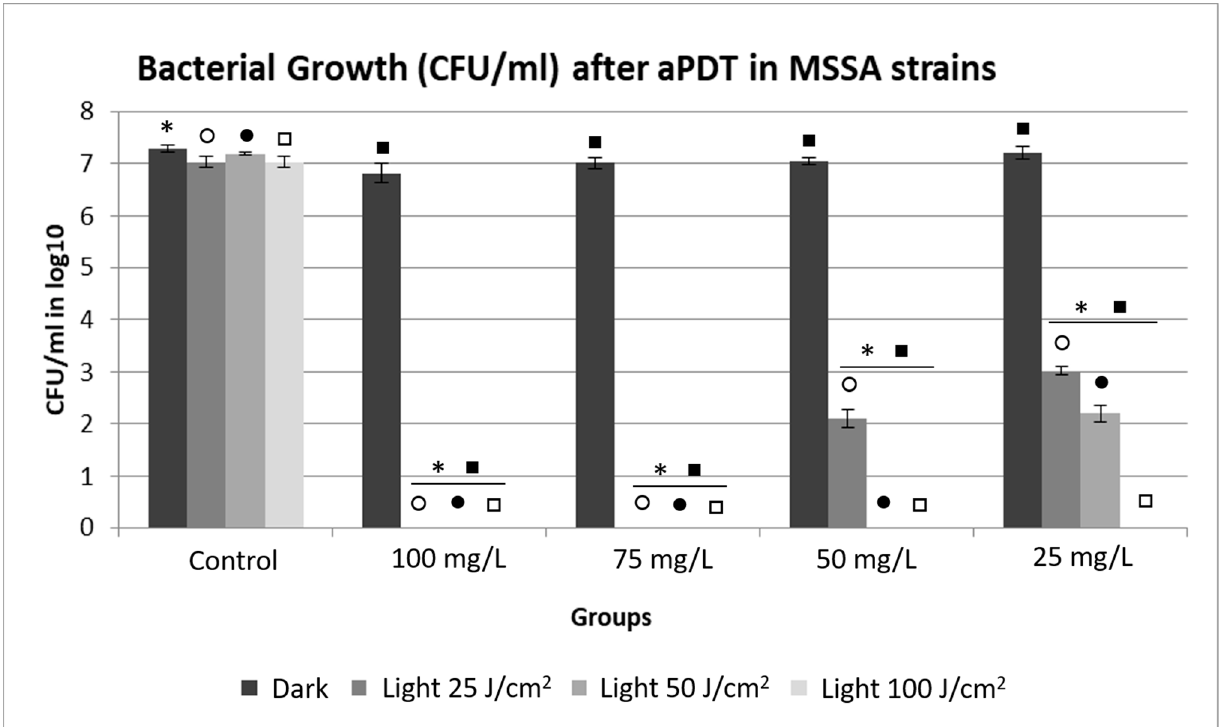
Figure 3. Average values of CFU/mL in log10 for MSSA strains, showing a Dark and Light control group, non-irradiated Photodithazine ® at 25, 50, 75, and 100 mg/L and irradiated at 25, 50, and 100 J/cm 2 . * Significant differences were observed between the Dark Control group to 100, 75, 50, and 25 mg/L with Dark, light 25, 50, and 100 J/cm 2 groups. ○ Significant differences were observed between the light 25 J/cm 2 Control group to 100, 75, 50, and 25 mg/L with light 25 J/cm 2 groups. ● Signi fi cant di ff erences were observed between the light 50 J/cm 2 Control group to 100, 75, 50, and 25 mg/L with light 50 J/cm 2 groups. □ Signi fi cant di ff erences were observed between the light 100 J/cm 2 Control group to 100, 75, 50, and 25 mg/L with light 100 J/cm 2 groups. ■ Significant differences were observed between the Dark 100, 75, 50, 25 µl/mL groups to 100, 75, 50, 25 mg/L with light 100, 75, 50, and 25 J/cm 2 groups.